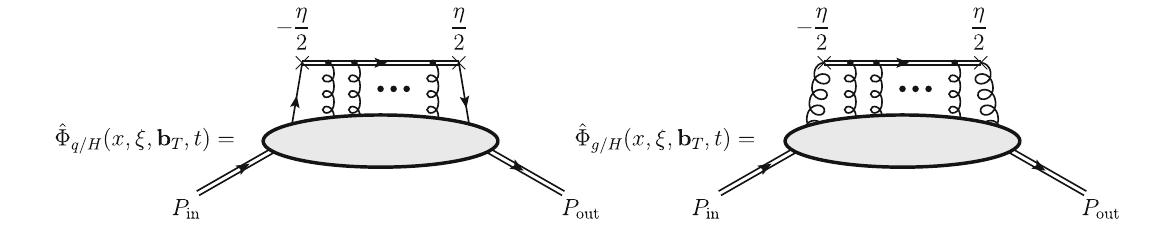
Fig. 1 Graphical representation of the quark (left) and gluon (right) unsubtracted GTMD correlators defined in Eq. (2)